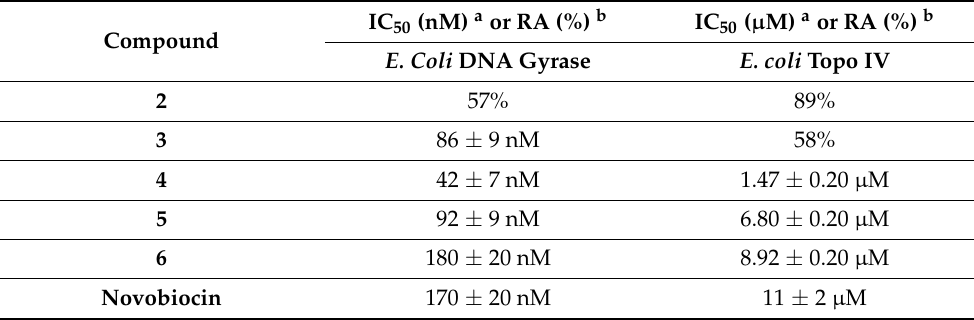
Table 3. E. coli DNA gyrase and topoisomerase IV inhibitory activities of compounds 2 – 6 and Novobiocin.